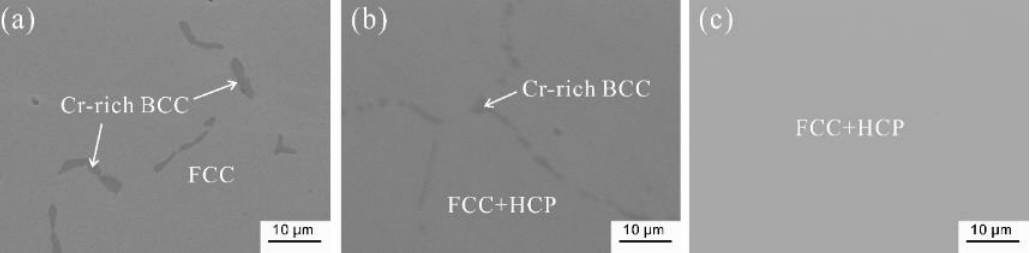
Figure 2. SEM images of the Co x CrFeMnNi 2 − x alloys annealed at 800 °C. ( a ) Co 25 Ni 15 ; ( b ) Co 30 Ni 10 ; ( c ) Co 35 Ni 5 . Table 1. The detected chemical composition of phases in the CoCrFeMn x Ni 2 − x alloys at the as-cast or annealed states.